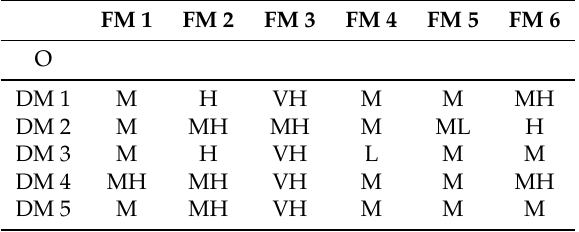
Table 7. The evaluations to failure modes from the FMEA